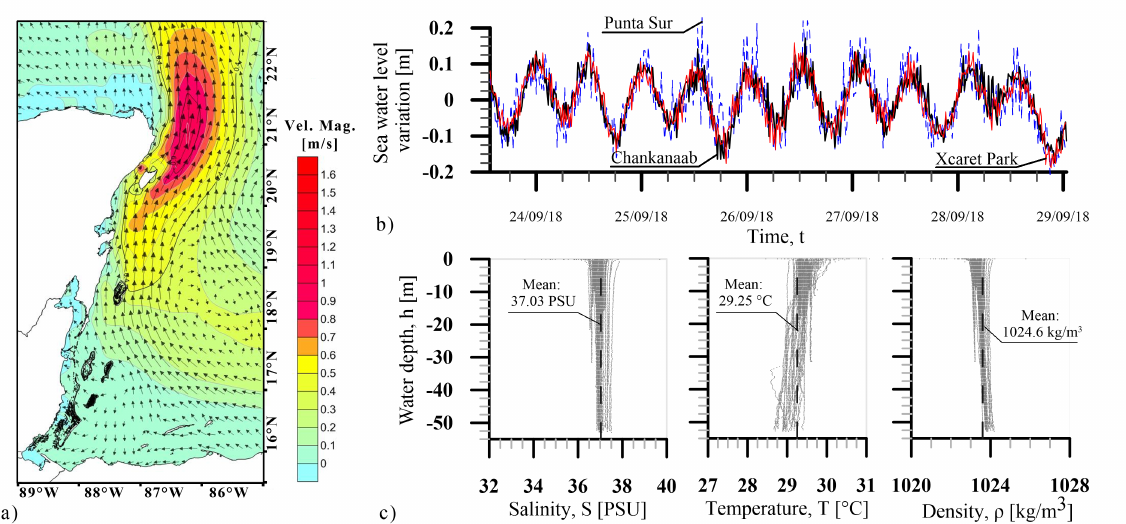
Figure 3. Flow velocity magnitudes and circulation of the Yucatan Current in the Caribbean Sea ( a ). Results of sea water level variations in Chankanaab, Punta Sur and Xcaret ( b ), from field measurements within the Channel as well as temperature, salinity and water density ( c ) during the field survey period (23–29 September